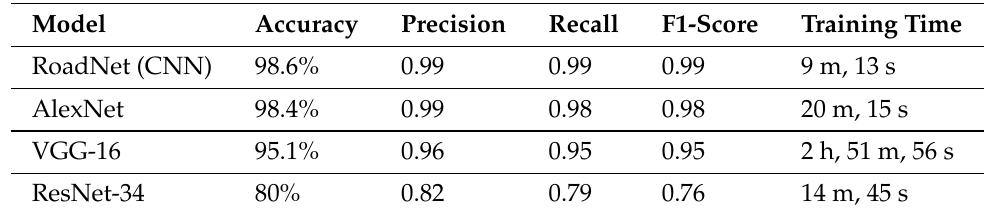
Table 6. Comparison between RoadNet, AlexNet, VGG-16, and ResNet-34 to classify road damage based on six different types of surface damage using our